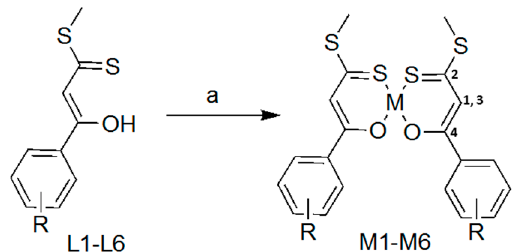
Table 1. Selected 1 H and 13 C NMR signals for compound 2 dissolved in CDCl 3 [ppm]. Ni, Pd, and Pt complexes show similar chemical shifts compared to the PtDMSO complex for signals 1–4 [18]. Chemical shifts differ from those observed for Ru and Os compounds